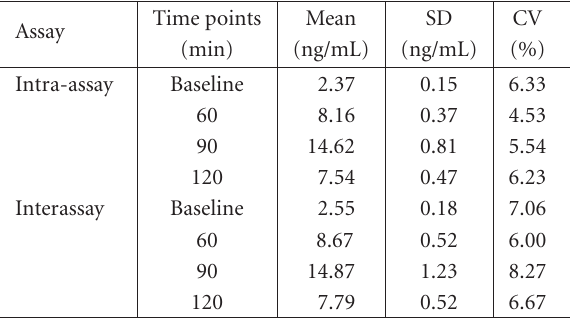
Table 1. Precision of hGH levels measured by anti-helix 4 sand- wich ELISA.